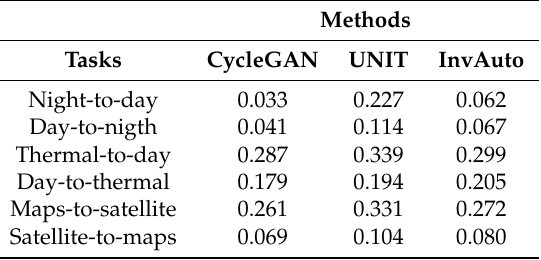
Table 3. Numerical evaluation of CycleGAN, UNIT, and InvAuto with (cid:96) 1 reconstruction loss.